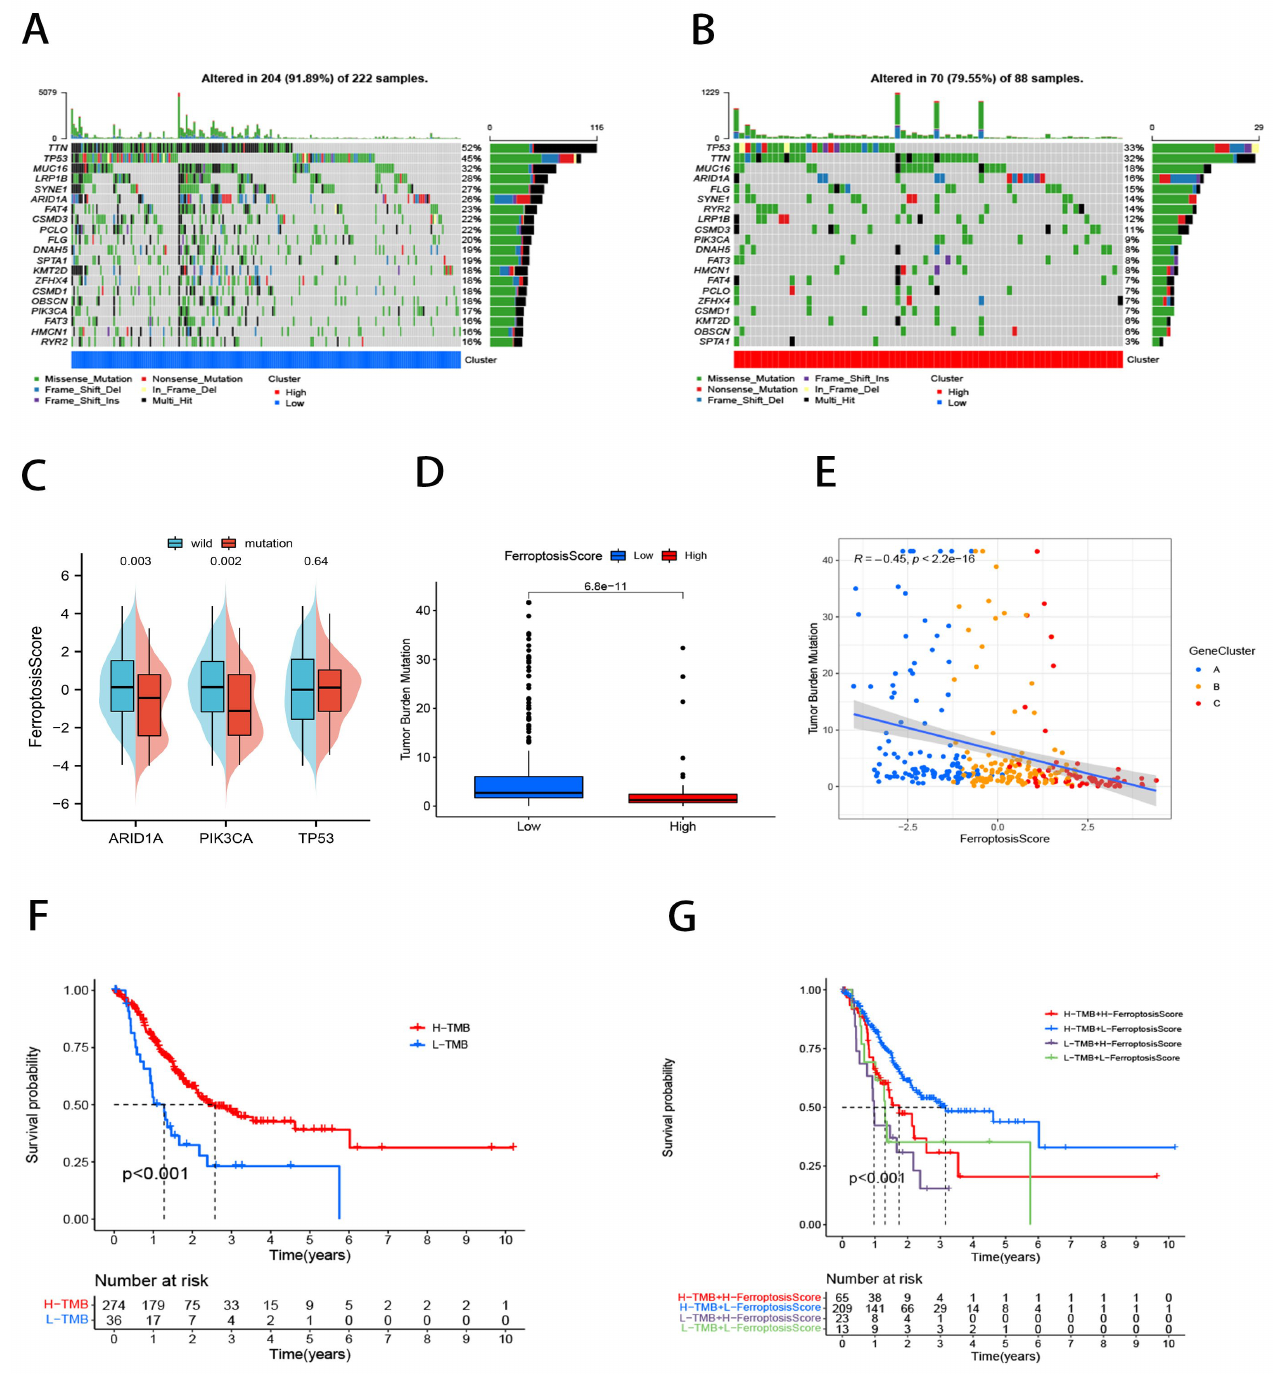
Figure 6. Tumor somatic cell mutation characteristics of ferroptosis score. ( A , B ) Waterfall plots of tumor somatic mutations in patients with low ( A ) and high ( B ) ferroptosis scores. Each column represents one patient. The top bar indicates the degree of tumor mutation. The numbers on the right indicate the frequency of mutations in each gene. The bars on the right show the proportion of different types of mutations. Stacked bar graphs show the conversion rate for each sample. ( C ) Ferroptosis scores differ between wild-type and mutant ARID1A , PIK3CA , and TP53 . ( D ) Box diagram illustrating the difference in tumor mutation burden between ferroptosis score groups. ( E ) Spearman’s Rank Correlation of ferroptosis score, tumor mutation burden, and gene clusters. ( F ) Kaplan–Meier curve for tumor mutation burden groupings. ( G ) Kaplan–Meier curve for ferroptosis and tumor mutation burden.